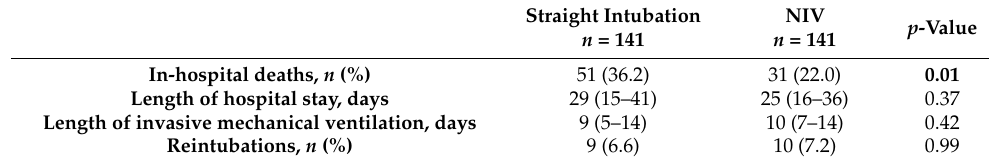
Table 2. Differences in major outcomes between groups.